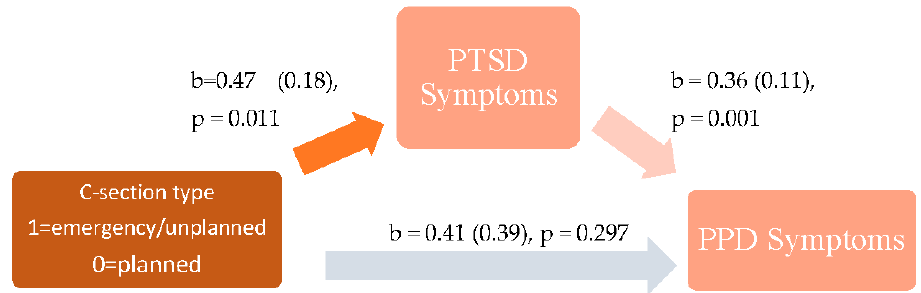
Figure 2. Adjusted model for the association between C-section type (i.e., emergency C-section compared to planned C-section) on PTSD and PPD symptoms.